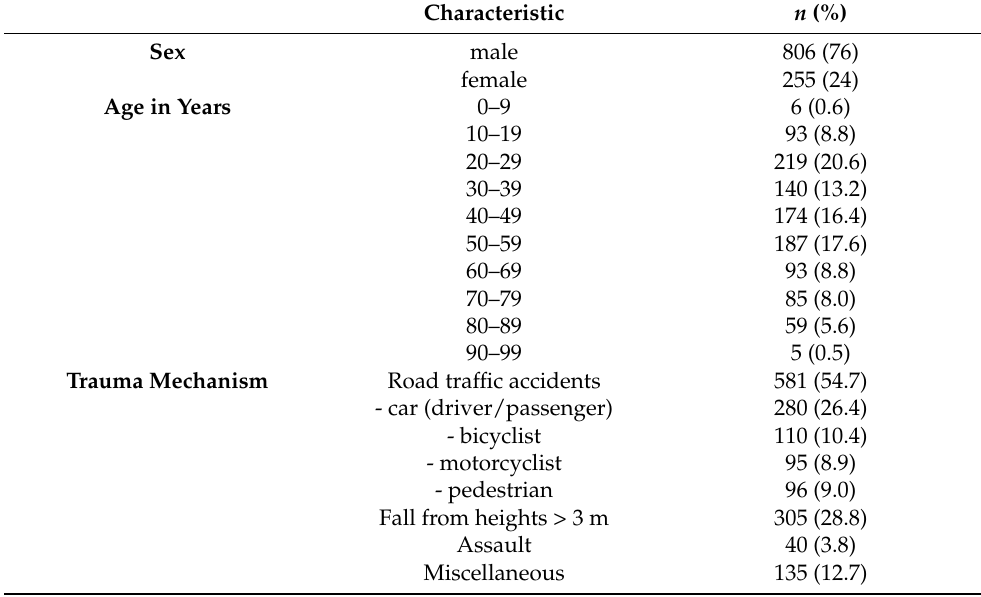
Table 1. Distribution of sex, age, and trauma mechanisms in the study